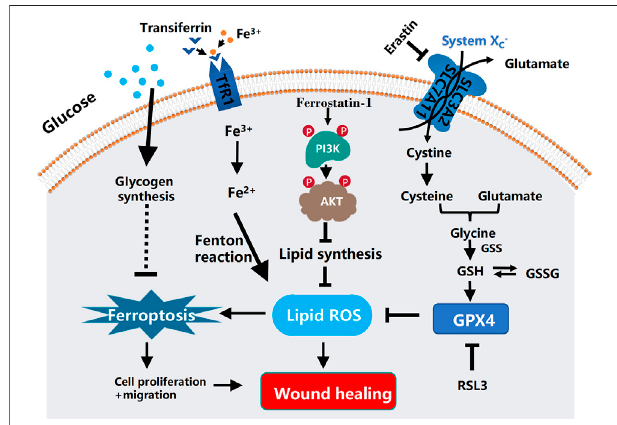
FIGURE 1 | Schematic diagram of the mechanism of ferroptosis in diabetic ulcers and the mechanism of ferrostatin-1 repairingdiabetic ulcers by inhibiting ferroptosis through PI3K-AKT. In diabetic ulcers, the synthesis of lipid peroxidation products is gradually increased as the increasing amount of glucose enters the cells. Under the action of intracellular iron ions, lipid peroxides continue to accumulate, thereby attacking cellular DNA and other biological macromolecules in the granulation tissue of ulcerated skin, ultimately triggering cellular ferroptosis. Ferrostatin-1, an inhibitor of ferroptosis, can reduce lipid peroxidative damage by activating the PI3K-AKT signaling pathway to block the pathway of ferroptosis, and at the same time promoting the regeneration, differentiation, and migration of vascular endothelial cells and epithelial cells, thereby effectively improving the ability of wound healing. In the process of ferroptosis, SLC7A11, SLC3A2, and the consume of glutathione lead to the accumulation of iron-dependent ROS. In addition, glucose and glutamine metabolism will decrease the levels of glutathioneandglutathioneperoxidase4(GPX4),resultingintheproductionof iron-independent reactive oxygen species. Ferroptosis is mediated by excess iron between cells. Ferric iron (Fe 3+ ) binds to transferrin and is imported into cellsthroughthemembraneproteintransferrinreceptor1(TfR1).Then,Fe3 + is reducedtoFe2+byreductase.Finally,excessintracellularirongeneratesROS through the Fenton reaction, which triggers ferroptosis.